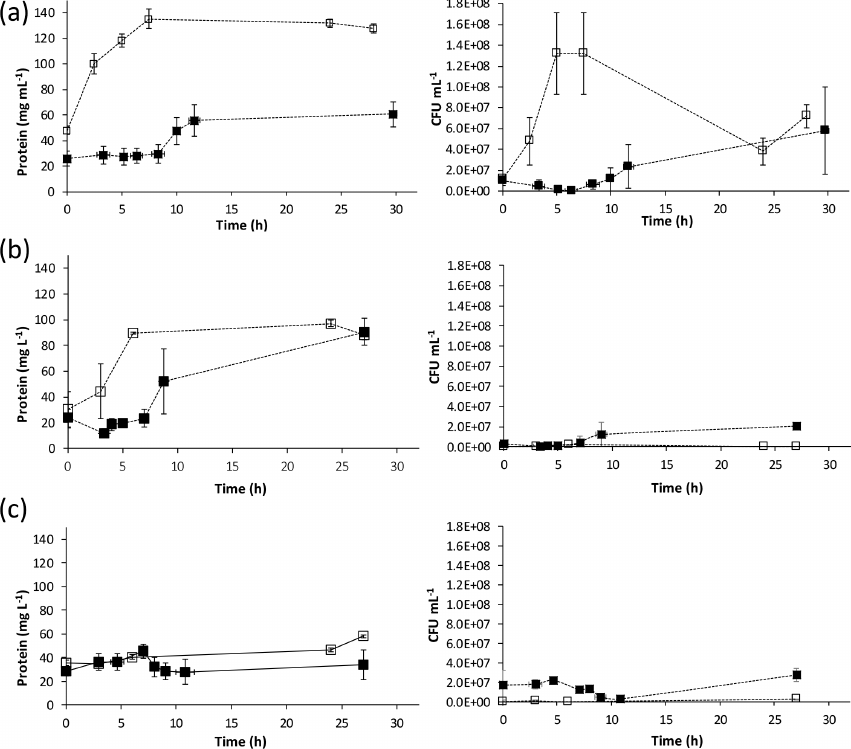
Figure 2. Change in protein concentrations and CFU mL − 1 over time for calcium-inclusive (solid markers) and calcium-exclusive (open markers). Aerobic media: (a) S. pasteurii , (b) B. sphaericus 21776 and (c) B. sphaericus 21787. Data points are the average of triplicate experiments; vertical error bars represent the standard deviation of triplicate experiments; horizontal error bars indicate standard deviation of the sampling